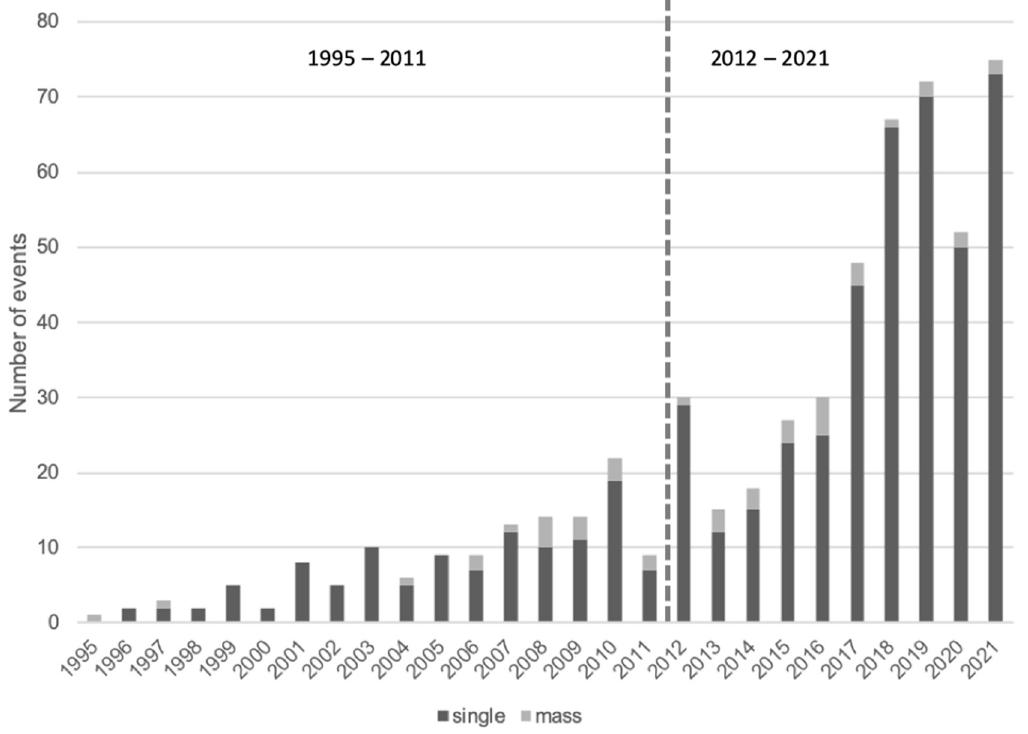
Figure 2. The annual trend of cetacean stranding events in Indonesia.